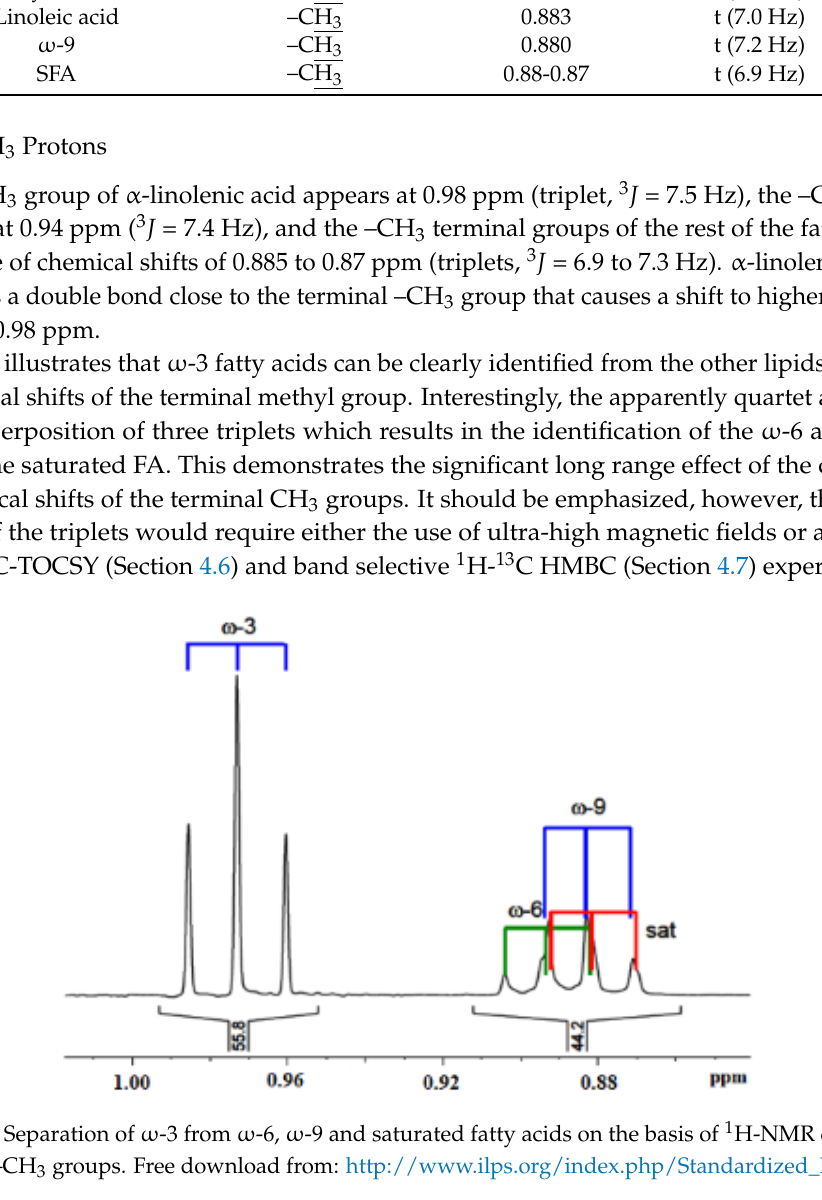
Table 9. 1 H-NMR resonance assignments of allylic protons, α-protons and CH 3 groups in CDCl 3 .